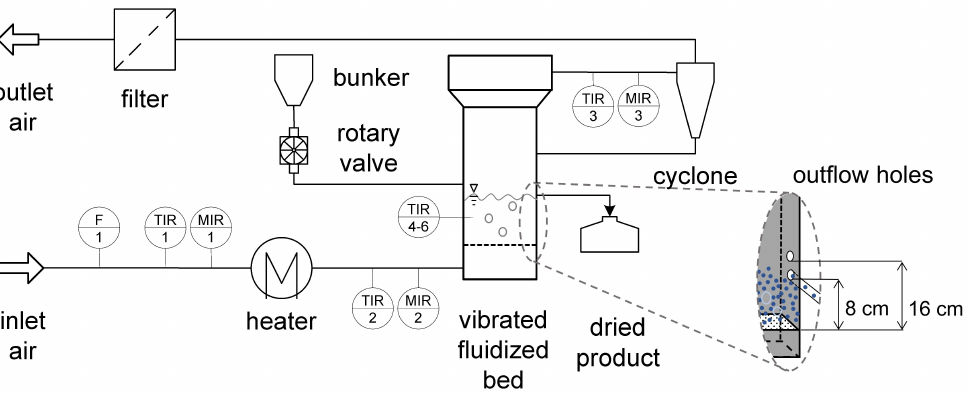
Figure 3. Simplified flow chart of the continuous vibrated fluidized bed (VFB) dryer, including relevant measurement locations and location of available outflow holes in the dryer